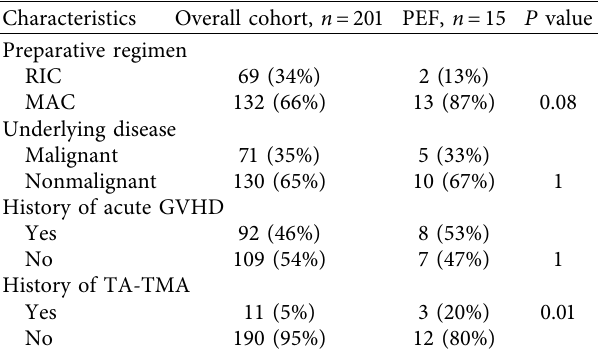
Table 2: Predisposing risk factors for PEF